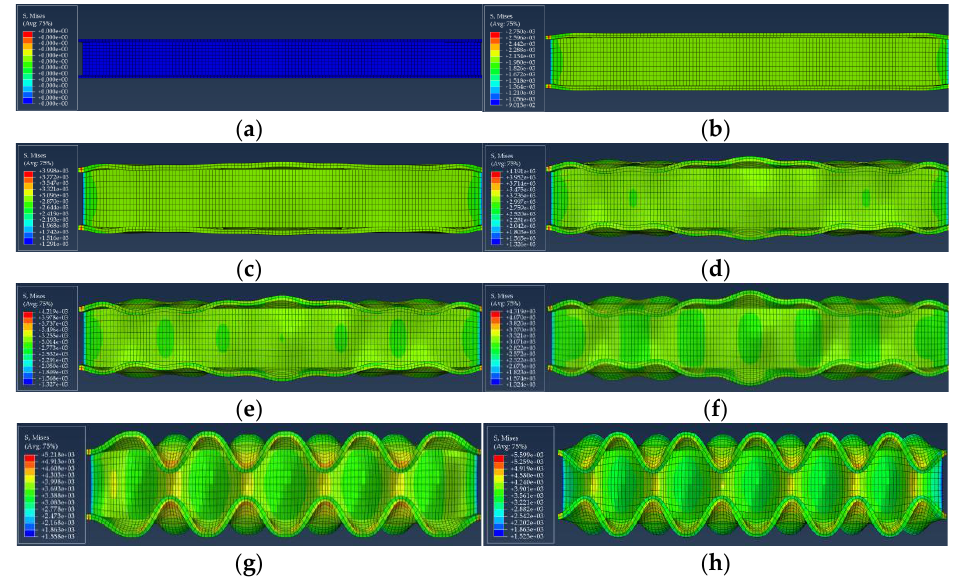
Figure 8. Elastic buckling development of the H-section steel core under monotonic compression. ( a ) ε = 0%. ( b ) ε = 1.02%. ( c ) ε = 1.46%. ( d ) ε = 1.50%. ( e ) ε = 1.51%. ( f ) ε = 1.52%. ( g ) ε = 1.83%. ( h ) ε =